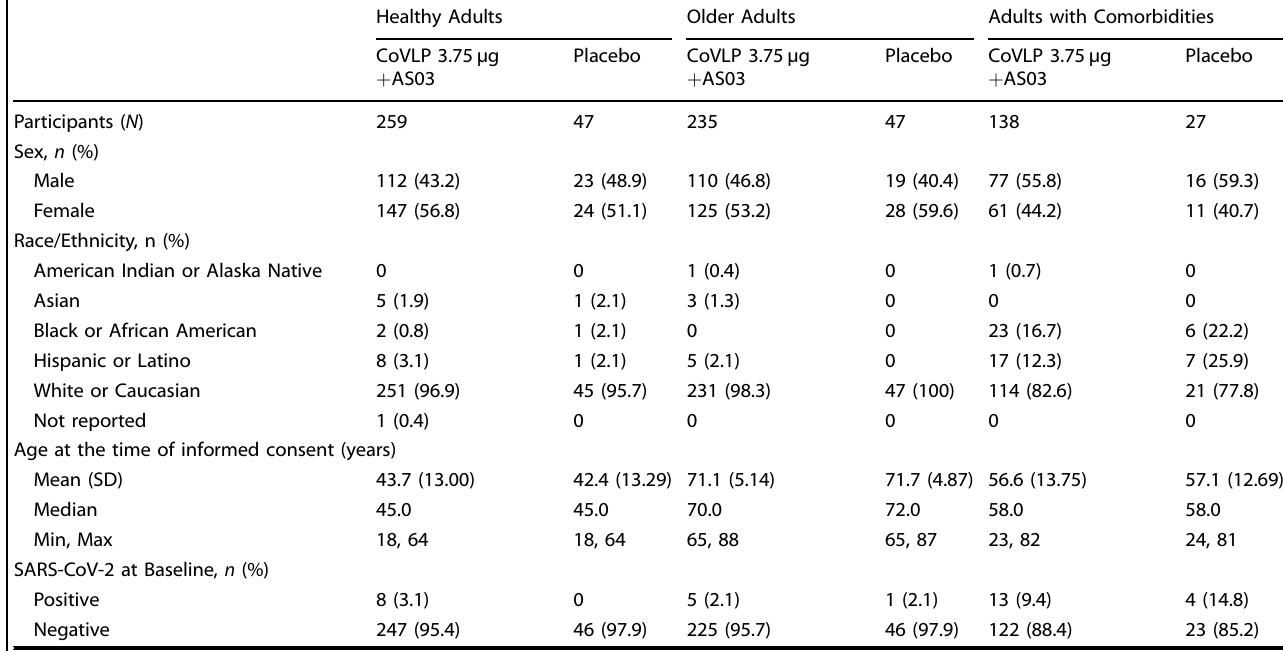
Table 1. Summary of demographics and baseline characteristics